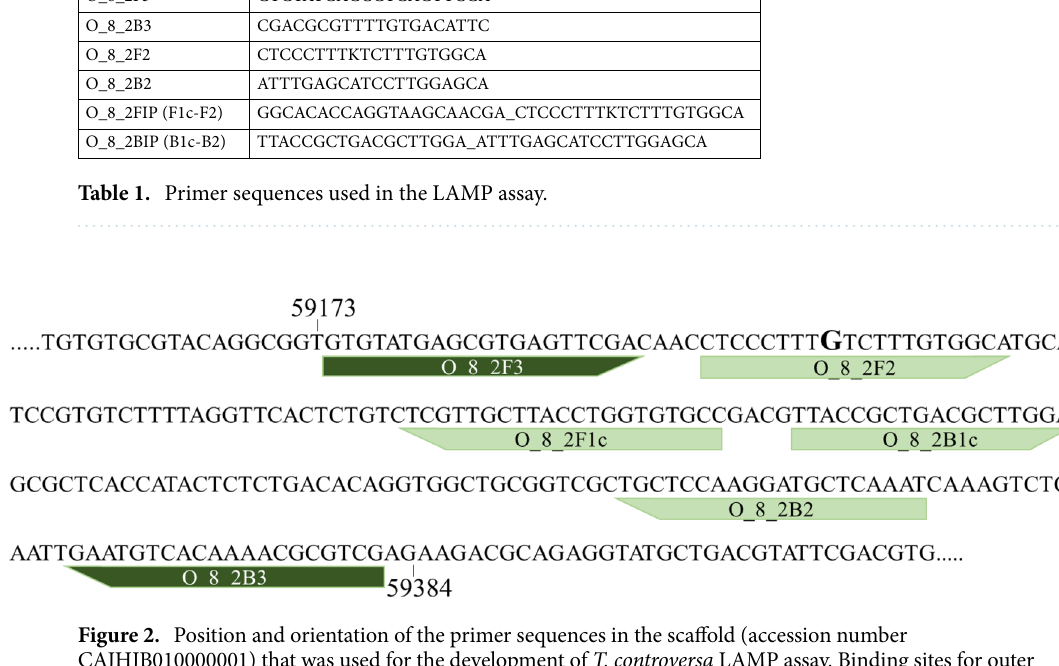
the genome analyses. Only one degenerate nucleotide (K) was introduced into one of the primers (Fig. 2) because at this position a double signal (T/G) was observed in the sequencing chromatogram of an individual isolate. No PCR product was obtained when a subset of DNA obtained from T. caries or T. laevis samples were used (Fig. 3).